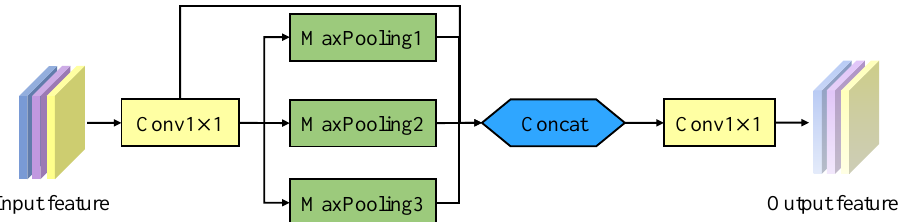
Figure 6. Spatial pyramid pooling